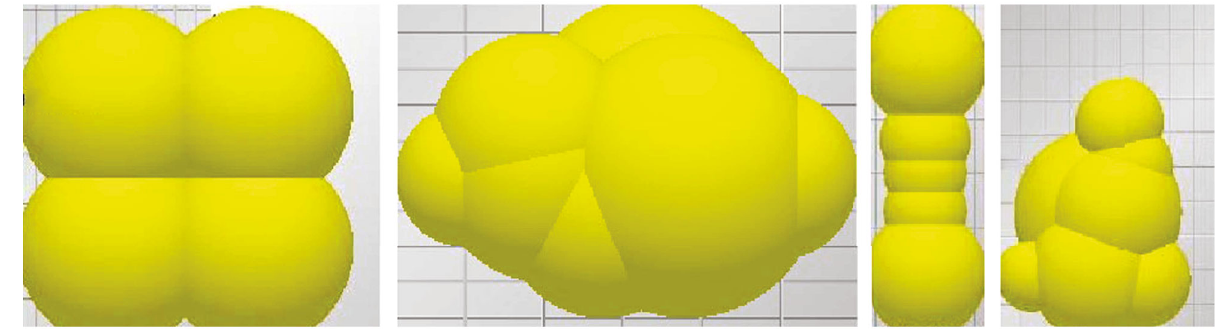
Figure 8: The simulated lunar soil particles established in